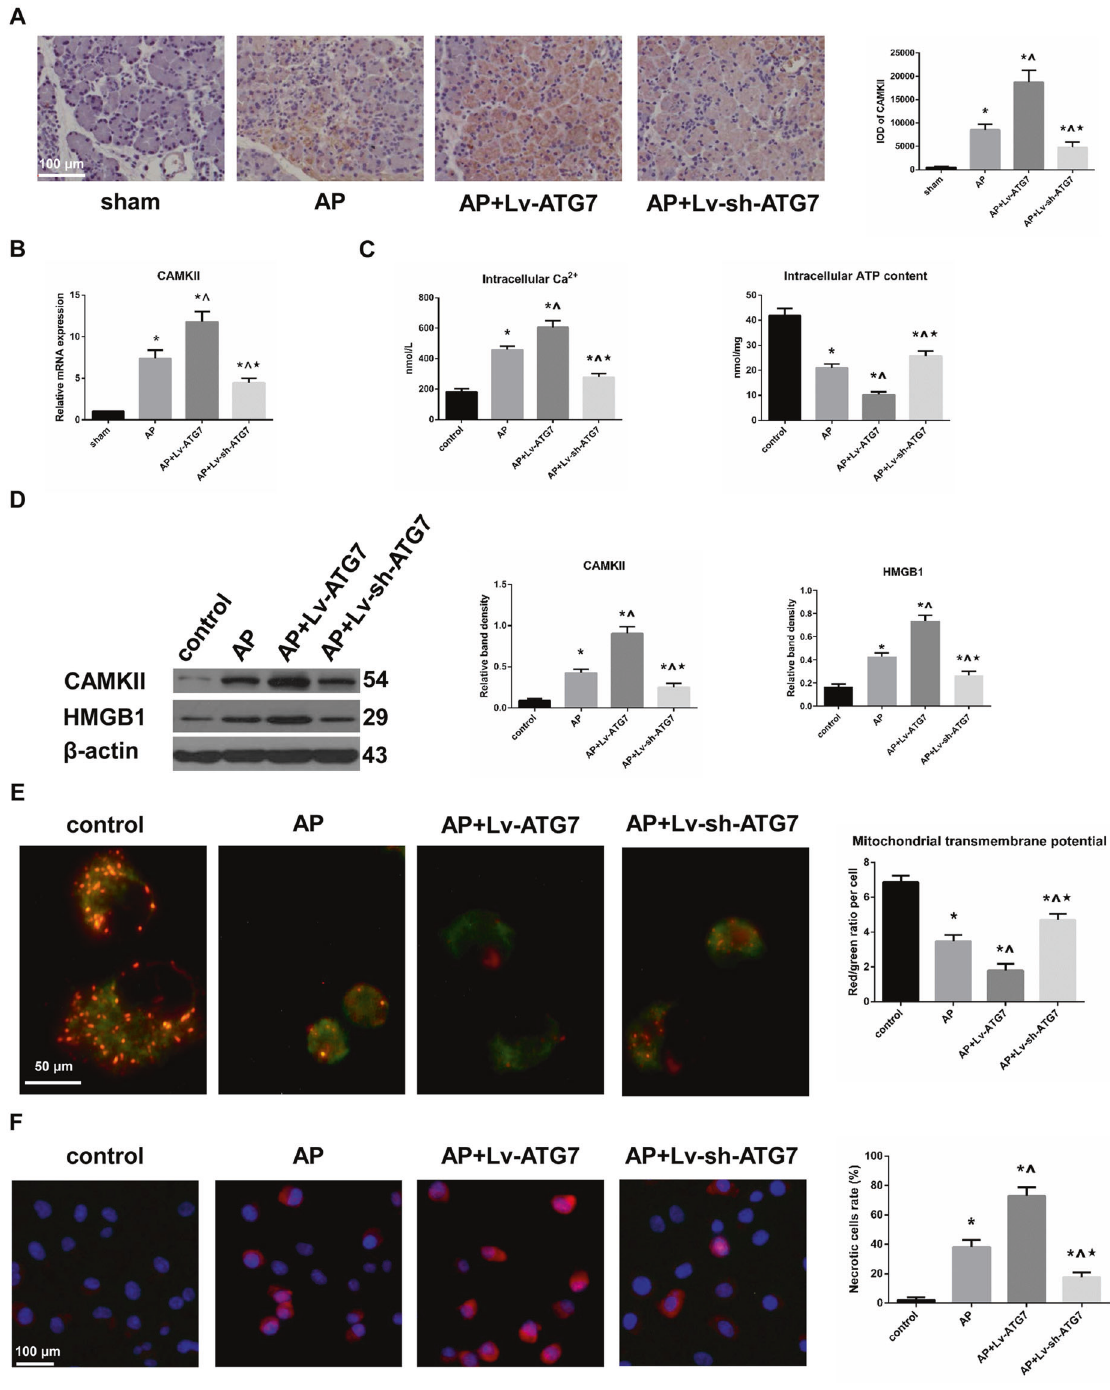
Fig. 3 ATG7 positively modulated the levels of CAMKII and necrosis following AP induction. A Representative IHC photographs of CAMKII expression in pancreatic tissues harvested from the rats as described in Fig. 2A. The corresponding IODs were analyzed with Image-Pro Plus v6.0 software. Bar = 100 μ m. B Levels of CAMKII mRNA in pancreatic tissues harvested from the rats as described in Fig. 2A. C Intracellular contents of ATP and Ca 2 + in cells that were subjected to control, AP, AP + Lv-ATG7 and Lv-sh-ATG7 for 3 h since AP induction. D Representative Western blot images and quanti fi cations of CAMKII and HMGB1 protein expression in cells mentioned above. β -actin was used as the protein loading control. E Representative fl uorescent images indicative of MTP by JC-1 staining in cells mentioned above, and the ratio of red/green fl uorescence was calculated to indicate MTP. Bar = 50 μ m. F Representative fl uorescent images indicative of necrosis and apoptosis by PI-Hoechst 33342 duo-staining in cells mentioned above, and the necrotic cells (indicated by a duo- fl uorescence of red and blue) rate was calculated. Bar = 100 μ m. Data were presented as mean ± SD ( N ≥ 3). ∗ P < 0.05 versus sham or control, ^ P < 0.05 versus AP, and * P < 0.05 versus AP + Lv − ATG7. AP acute pancreatitis, ATP adenosine triphosphate, CAMKII calcium/calmodulin-dependent protein kinase II, HMGB1 high mobility group protein B1, IHC immunohistochemistry, IOD integrated optical density, MTP mitochondrial transmembrane potential, PI propidium iodide, SD standard